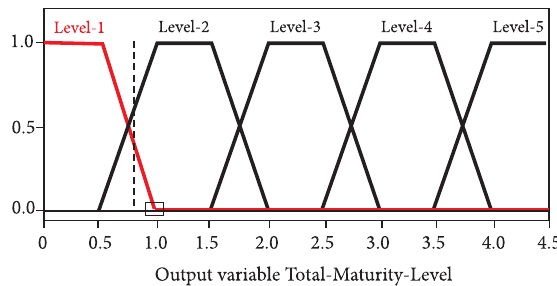
Figure 5. Final output of ES5_Total Maturity